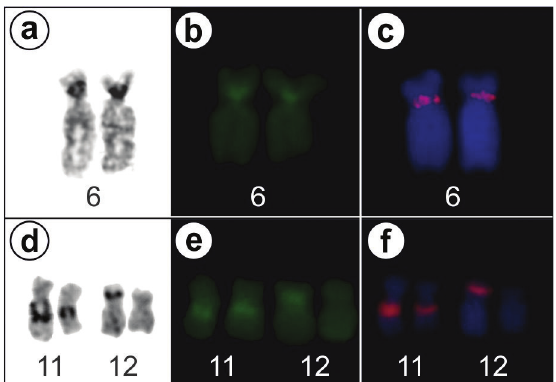
Figure 4. Nucleolus organizer regions in Ololygon obtriangulata ( a, b, c ) and Scinax fuscovarius ( d, e, f ) identified by a, d silver impregnation b, e CMA staining, and c, f FISH with rDNA probe. 3